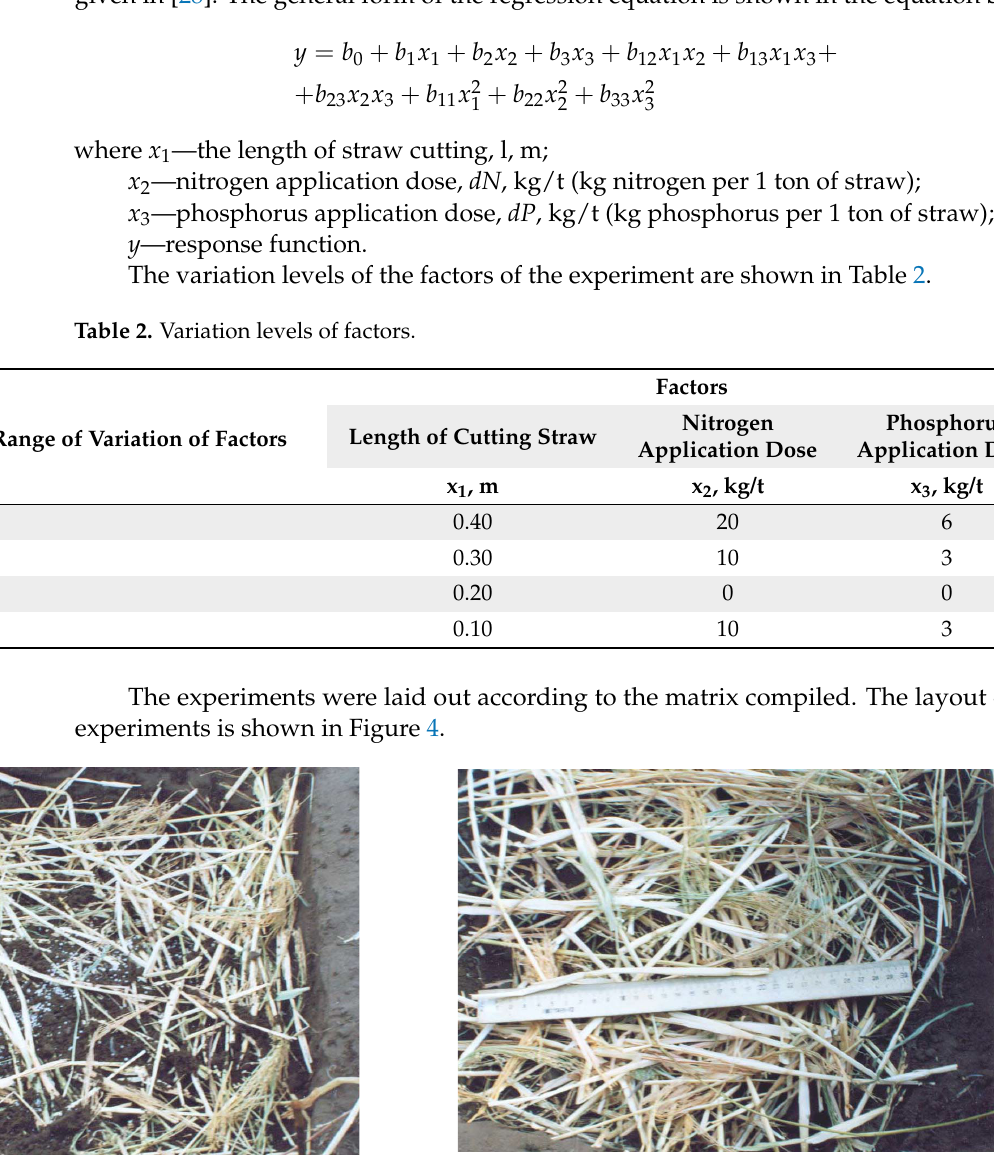
Figure 4. Layout of the experiments in the study of the straw decomposition process.